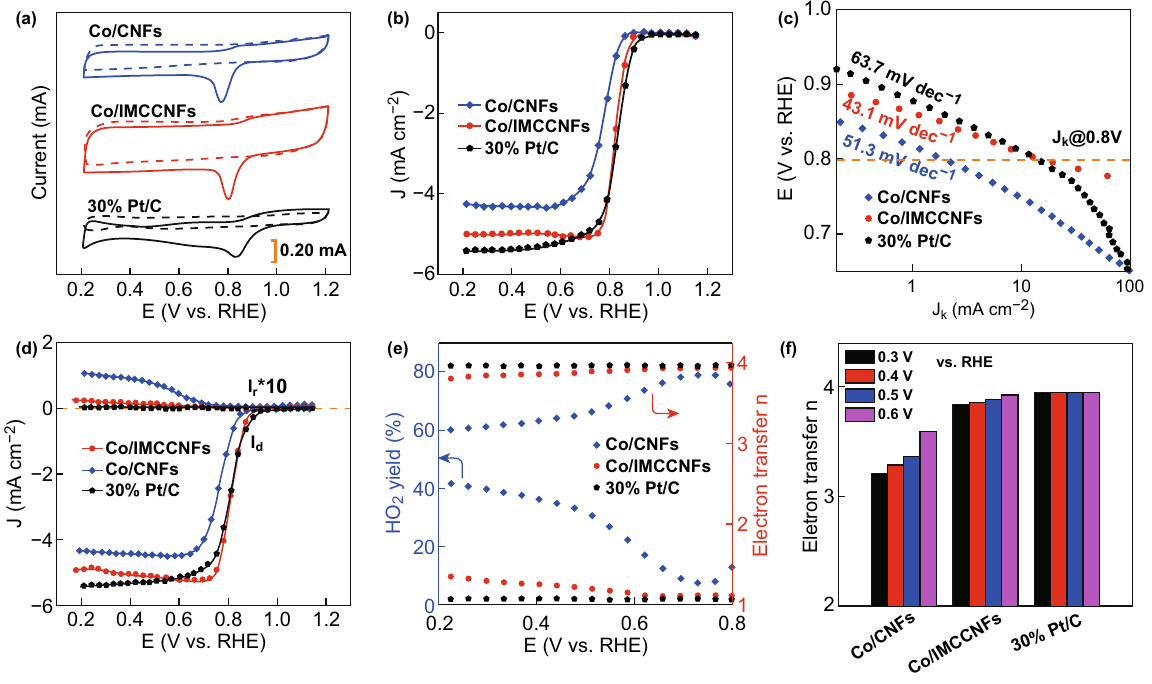
Fig. 4 a CV curves of 30% Pt/C, Co/IMCCNFs, and Co/CNFs on glassy carbon electrodes in O 2 -saturated (solid curve) and N 2 -saturated (dashed curve) 0.1 M KOH electrolytes. b, c RDE voltammograms and corresponding Tafel plots of 30% Pt/C, Co/IMCCNFs, and Co/CNFs. d RRDE voltammograms recorded with Co/IMCCNFs and 30% Pt/C in the O 2 -saturated 0.1 M KOH at 1600 rpm. e Percentages of peroxide (lower line) and electron transfer numbers ( n ) (upper line) of 30% Pt/C, Co/IMCCNFs, and Co/CNFs calculated using the RRDE data in ( d ). f Electron transfer numbers of 30% Pt/C, Co/IMCCNFs, and Co/CNFs at potentials of 0.3, 0.4, 0.5, and 0.6 V (vs.